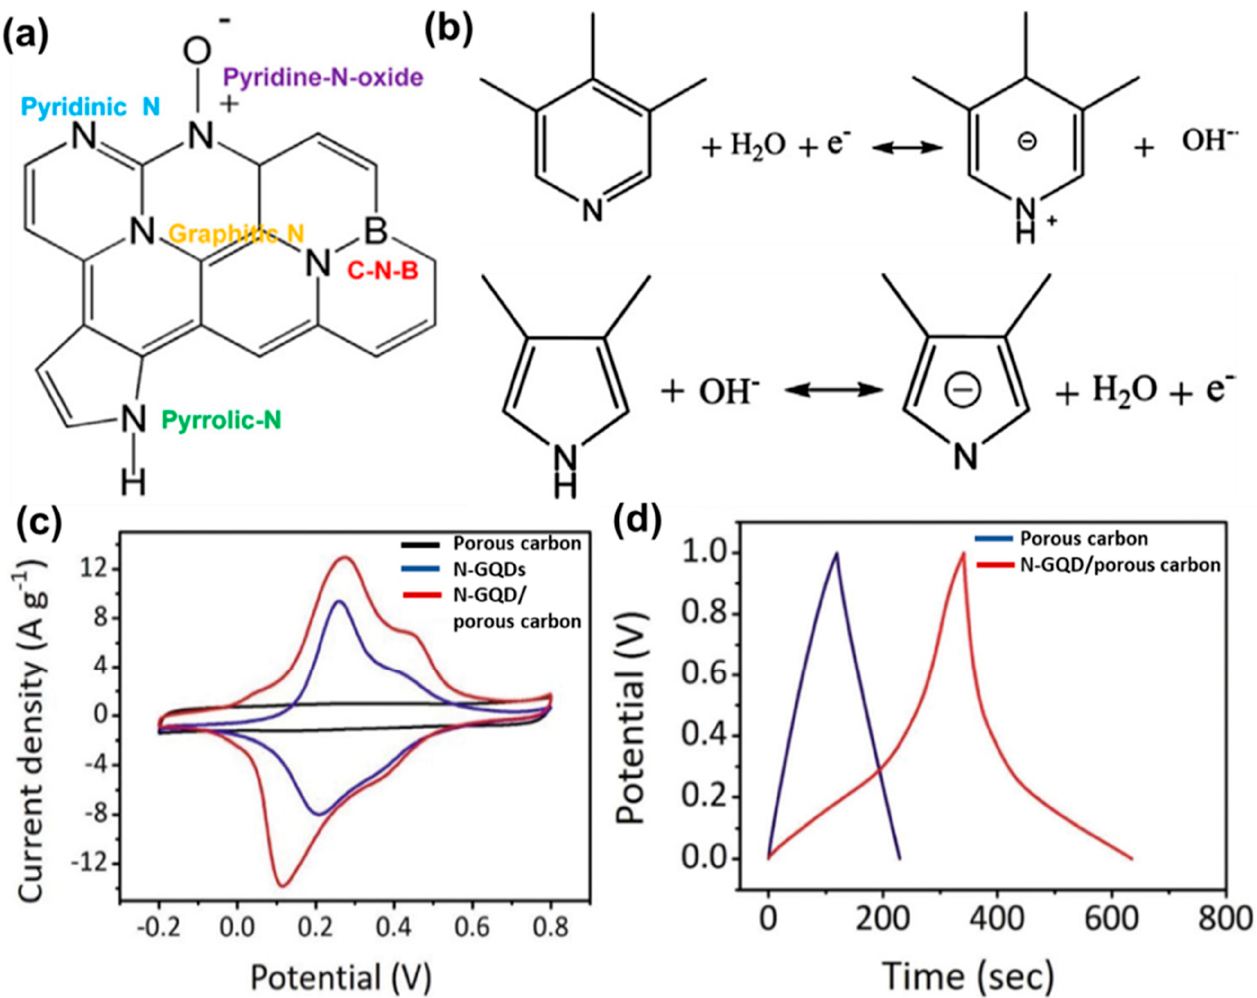
Figure 13. ( a ) Schematic representation for the hetero atom doped graphitic nano structure. ( b ) Pro- posed pseudocapacitive reactions for the nitrogen-containing species. Reprinted with permission from Ref. [121]. ( c ) Cyclic voltammetry plots for porous carbon, N-GQDs, and N-GQDs/porous carbon electrodes at 10 mV s − 1 scan rate and in 1.0 M H 2 SO 4 electrolyte. ( d ) Galvanostatic charge–discharge plots for the supercapacitor electrodes at 0.5 A g − 1 current density. Reprinted with permission from Ref. [108]. Table 1. Specific surface area and series resistance (Rs) or the charge transfer resistance (Rct) changes due to incorporation of GQDs in the composite electrode materials.